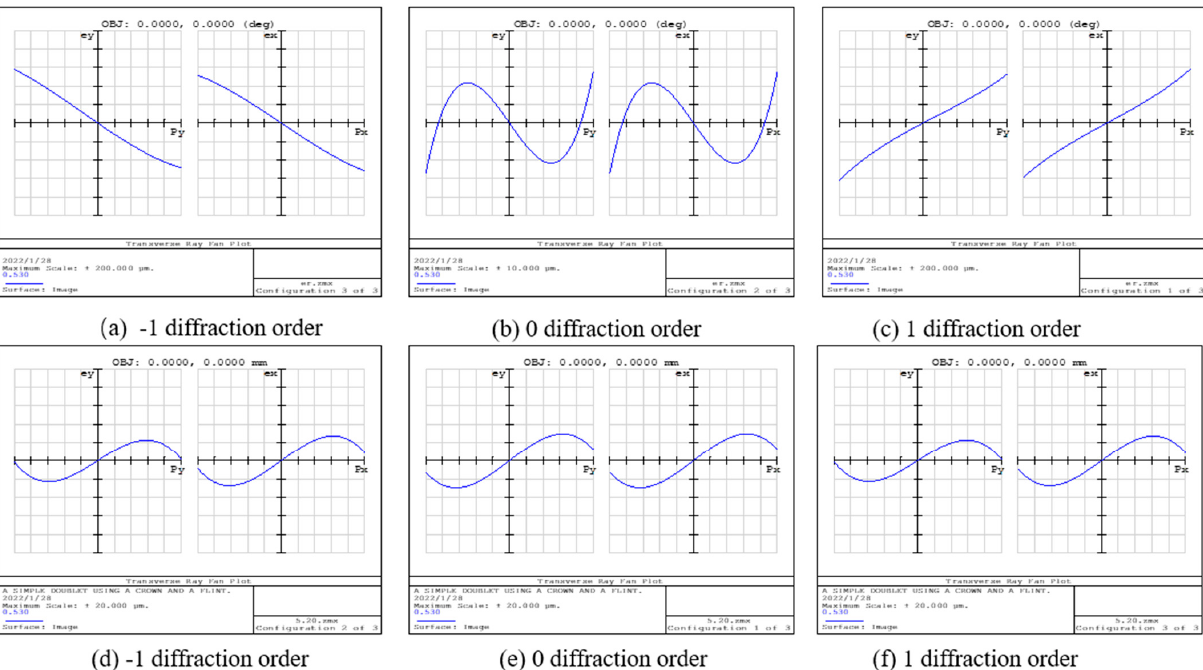
Figure 4. Light sectors calculated by ZEMAX in three orders for the 3D chromatography microscope system before and after aberration correction. ( a – c ) Light sectors corresponding to different diffraction levels of unmodified chromatography microscope system. ( d – f ) Light sectors corresponding to different diffraction levels of the aberrated chromatography microscope system.